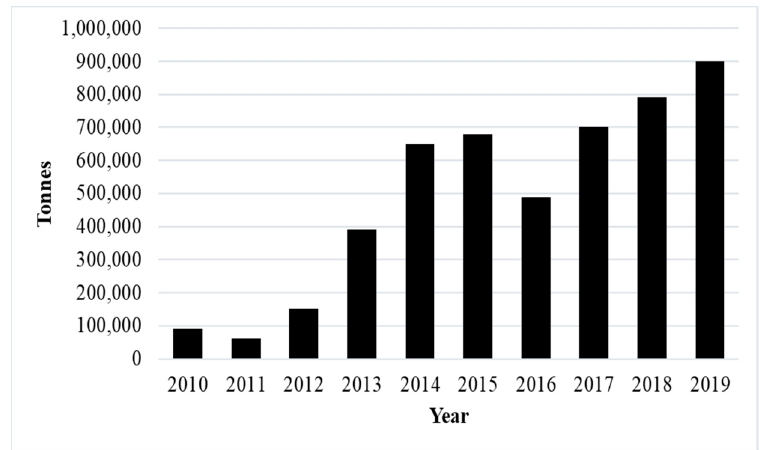
Figure 6. Production of biodiesel in Malaysia from 2010 to 2019 [32].